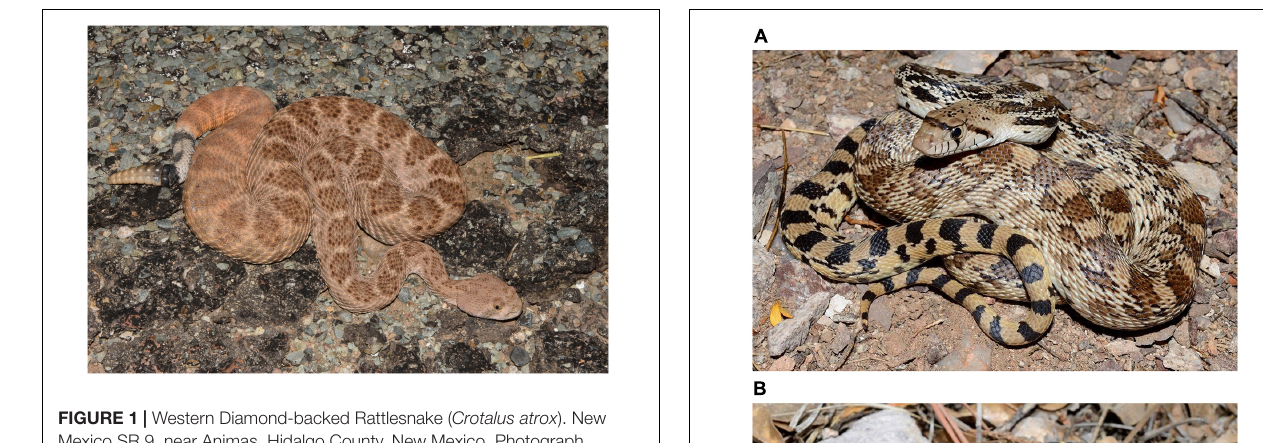
FIGURE 1 | Western Diamond-backed Rattlesnake ( Crotalus atrox ). New Mexico SR 9, near Animas, Hidalgo County, New Mexico. Photograph courtesy of William Wells.